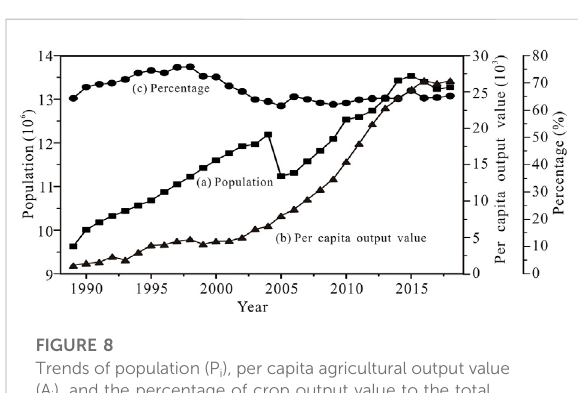
FIGURE 8 Trends of population (P i ), per capita agricultural output value (A i ), and the percentage of crop output value to the total agricultural output value (I i ) in Xinjiang from 1989 to